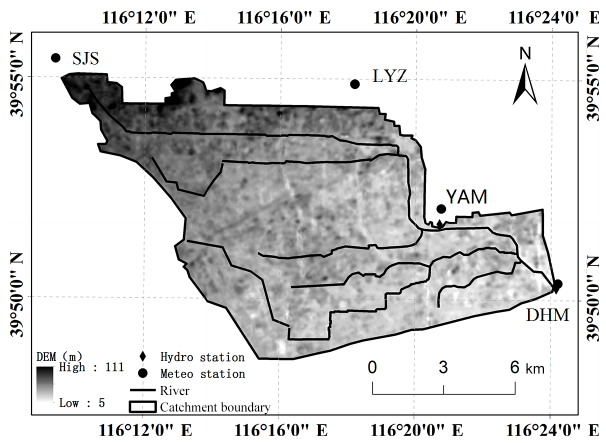
Figure 1. Location, river systems, and hydrometeorological sta- tions in the Dahongmen catchment.